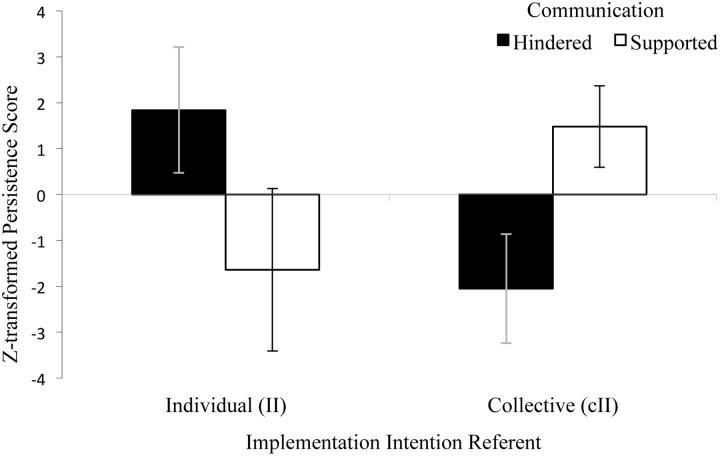
z-transformed persistence scores by Implementation Intention Referent and Communication (Experiment 2). Error bars represent standard errors. II: Individual implementation intention, cII: collective implementation intention.